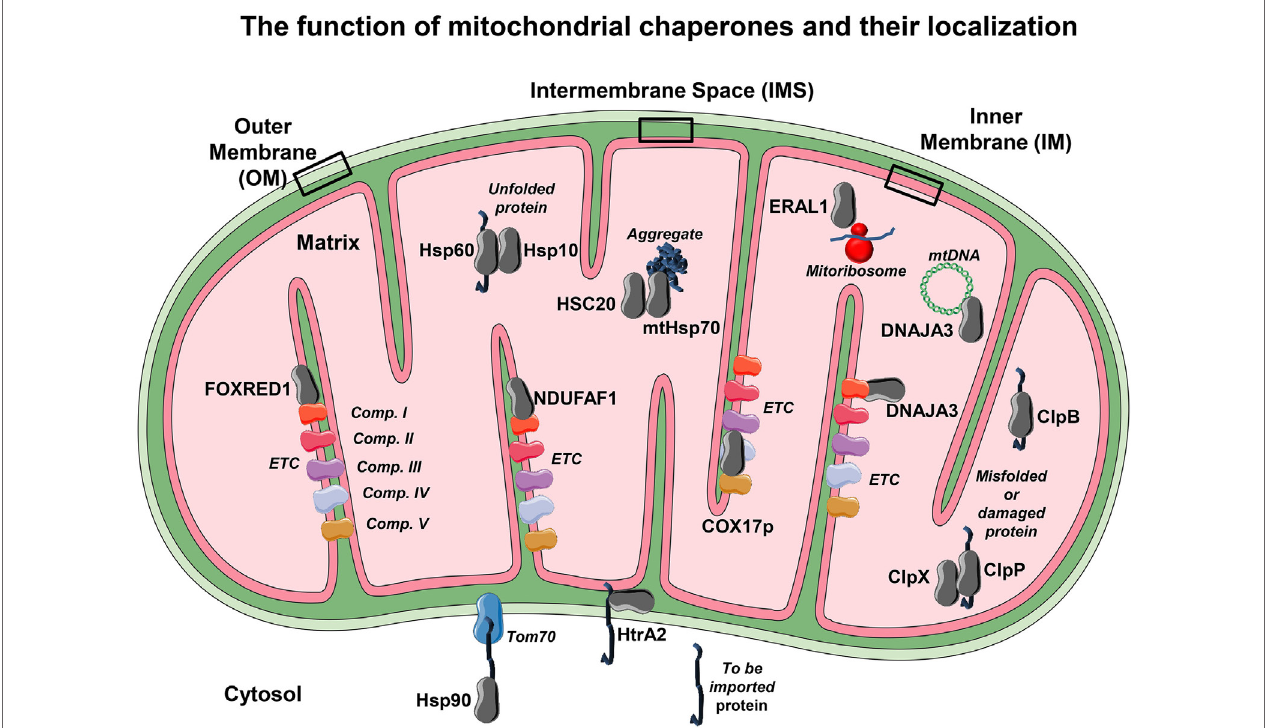
FiGUre 2 | The mitochondrial chaperones localization. Due to the elevated mitochondrial activity in each compartment, it becomes necessary to employ mitochondrial chaperones to ensure proper function. The localization of several chaperones and co-chaperones and their association with several of their targets is shown. Each chaperone or co-chaperone is placed in different mitochondrial compartments such as outer membrane (OM), inner membrane (IM), intermembrane space (IMS), and the matrix according to their main function. From the cytosol to the OM, Hsp90 assists the delivery of to-be-imported proteins to the mitochondrial translocase Tom70. Within the IMS, several chaperones such as HtrA2 allow unfolded proteins to translocate from OM to the IM and avoid degradation. On the IM reside the electron transport chain (ETC) proteins, so there are several IM chaperones that have the ability to bind and guarantee proper folding and function to ETC complexes such as NDUFAF1 and FAD-dependent oxidoreductase-containing domain 1 , which bind to NADH:ubiquinone oxidoreductase (complex I). Moreover, COX17p binds to cytochrome C oxidase (complex IV) and helps with its assembly. It is however on the matrix that most of the mitochondrial chaperones or co-chaperones are localized. For example, the chaperone heat shock protein 60 cooperates with its co-chaperone Hsp10 in order to promote correct protein folding. The mtHsp70 and its co-chaperone HSC20 help to promote protein folding and avoid protein aggregation, a detrimental feature that leads to mitochondrial dysfunction. Other chaperones exhibit more than one task. This is the case of DNAJA3, a chaperone that avoids complex I aggregation but is also able to assist mitochondrial DNA maintenance. Other crucial processes such as mitochondrial protein synthesis rely on a proper mitoribosome assembly, a task that is employed by the RNA chaperone ERAL1. In order to keep mitochondria homeostasis—besides correct (re)folding and synthesis—protein degradation is also mandatory. To this effect, mitochondria have proteases such ClpP and ClpX that play a role in degrading no longer required, misfolded, or damaged proteins, and ClpB mainly as a chaperonin and a disaggregase. The conformational display of each protein or complex and binding layout is merely